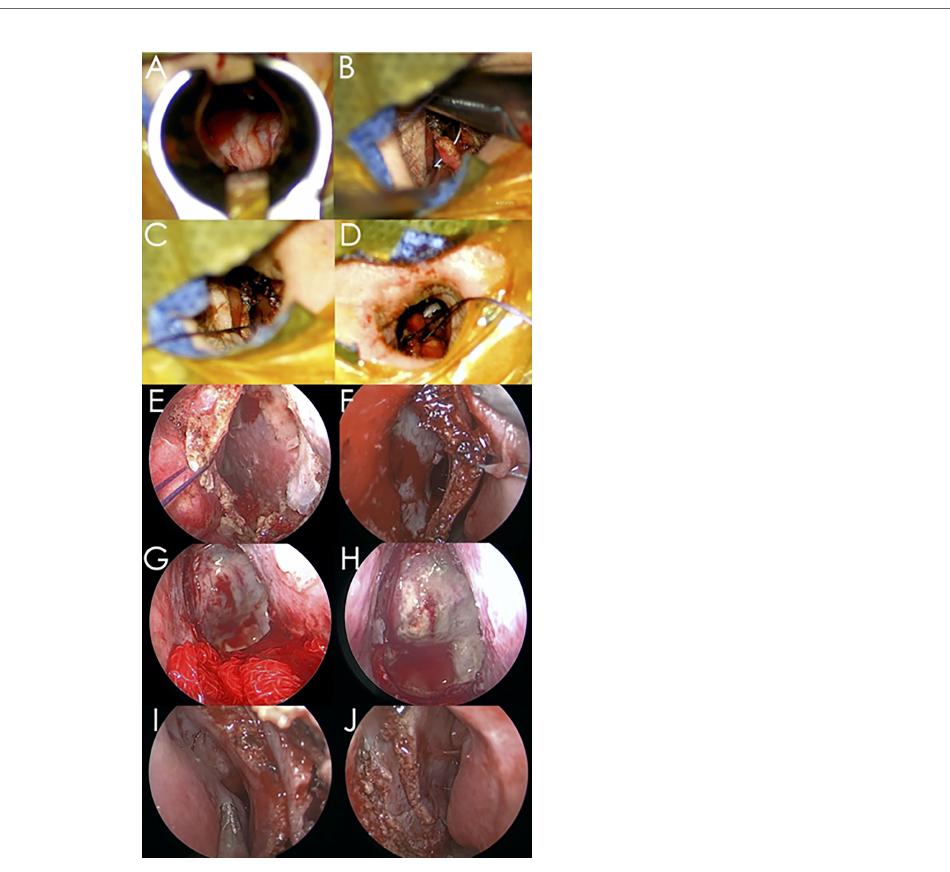
FIGURE 1 | Representative surgical procedure images involved in the modi fi ed microscopic-endoscopic bilateral transseptal transsphenoidal approach. (A) Removal of the bony sellar fl oor using the uninostril microscopic technique. (B) Make a tagging suture on the left septal mucosa. (C) Suture between the left septal mucosa fl ap and the surgical drapes. (D) Suture between the right septal mucosa fl ap and surgical drapes. (E) Endoscopic view of the right nostril entrance. (F) Endoscopic view of the left nostril entrance. (G) Two epinephrine gauze strips were placed between the septal mucosa fl aps to maintain the surgical corridor. (H) Endoscopic view of the seller fl oor and internal part of the olfactory cleft area mucosa. (I) Inspection of the right nasal cavity and repositioning of the septal mucosa fl ap. (J) Inspection of the left nasal cavity after fi nal inspection. Asterisk: internal part of the olfactory cleft area mucosa.